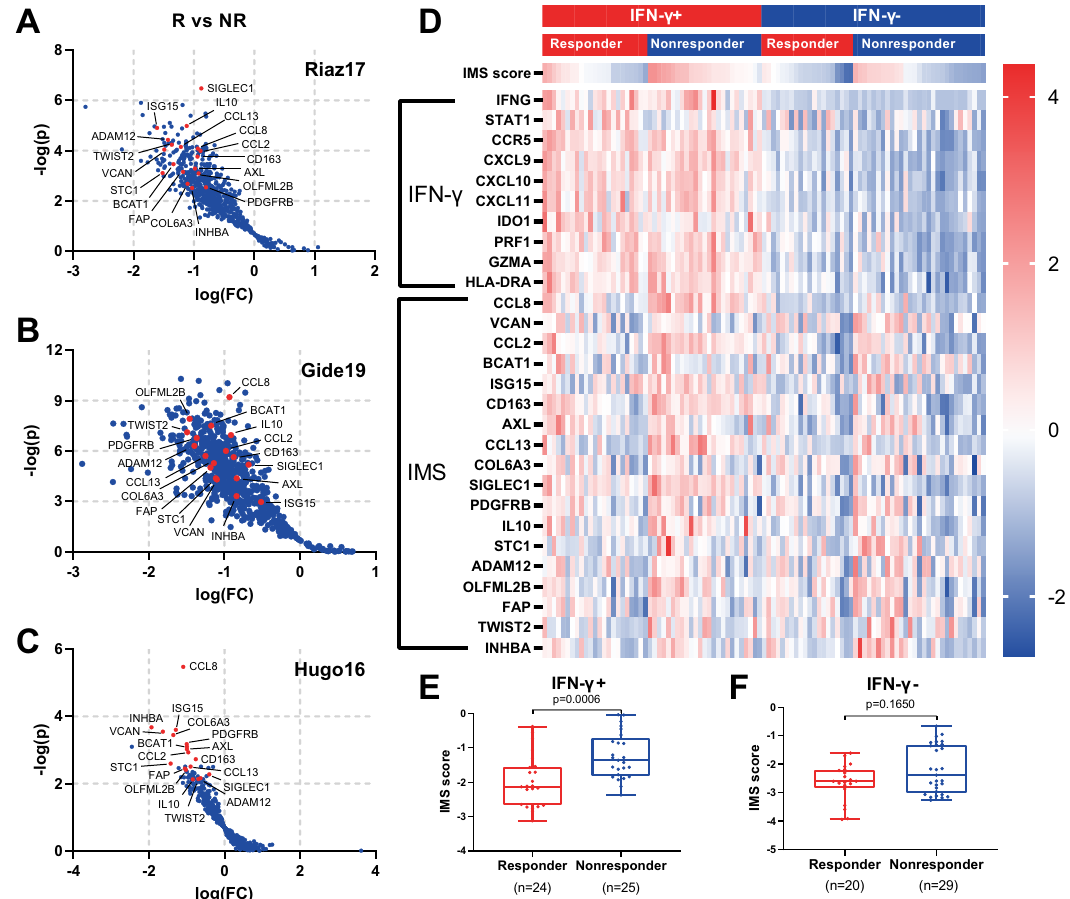
Fig. 1 The de fi nition of the IMS genes. A – C Volcano plot depiction of differentially expressed genes after normalization by the IFN- γ score of individual sample by response on Riaz17 (in A , n = 51), Gide19 (in B , n = 41) and Hugo16 (in C , n = 28). R, responders (CR or PR); NR, nonresponders (PD) as per RECIST 1.1. IMS genes are highlighted in red. D Heatmap showing the expression of genes from the IFN - γ signature and the IMS strati fi ed by IFN - γ and response to anti-PD-1 therapy. Rows represent genes and columns represent patients. The expression levels were z-normalized within rows for visualization. The cutoff value for the IFN - γ signature score was set to its median. The IMS scores in responders versus nonresponders for IFN- γ + ( E ) and IFN- γ − ( F ) Respective biological functions of IMS genes are listed in Supplementary Table 1.